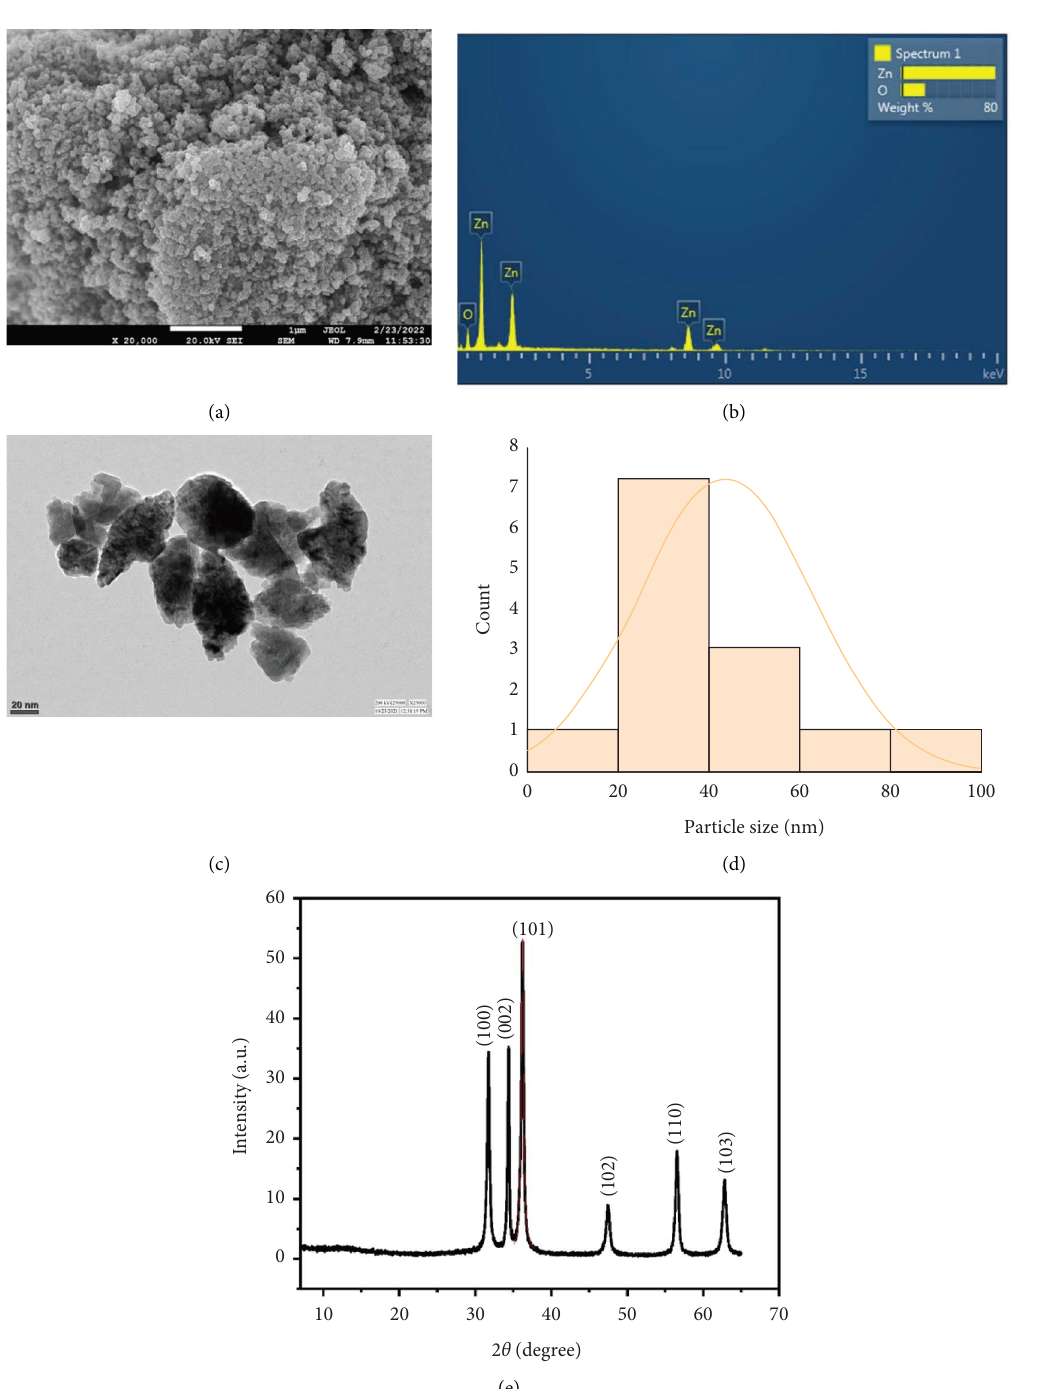
Figure 5: (a) SEM image and (b) EDX spectrum of ZnO NPs. (c) Zinc oxide nanoparticles under a TEM microscope. (d) Particle size distribution of ZnO NPs is represented by the histogram (TEM method) with an average size between 20 and 40 nm. (e) X-ray difractometer (XRD) spectra of synthesized ZnO